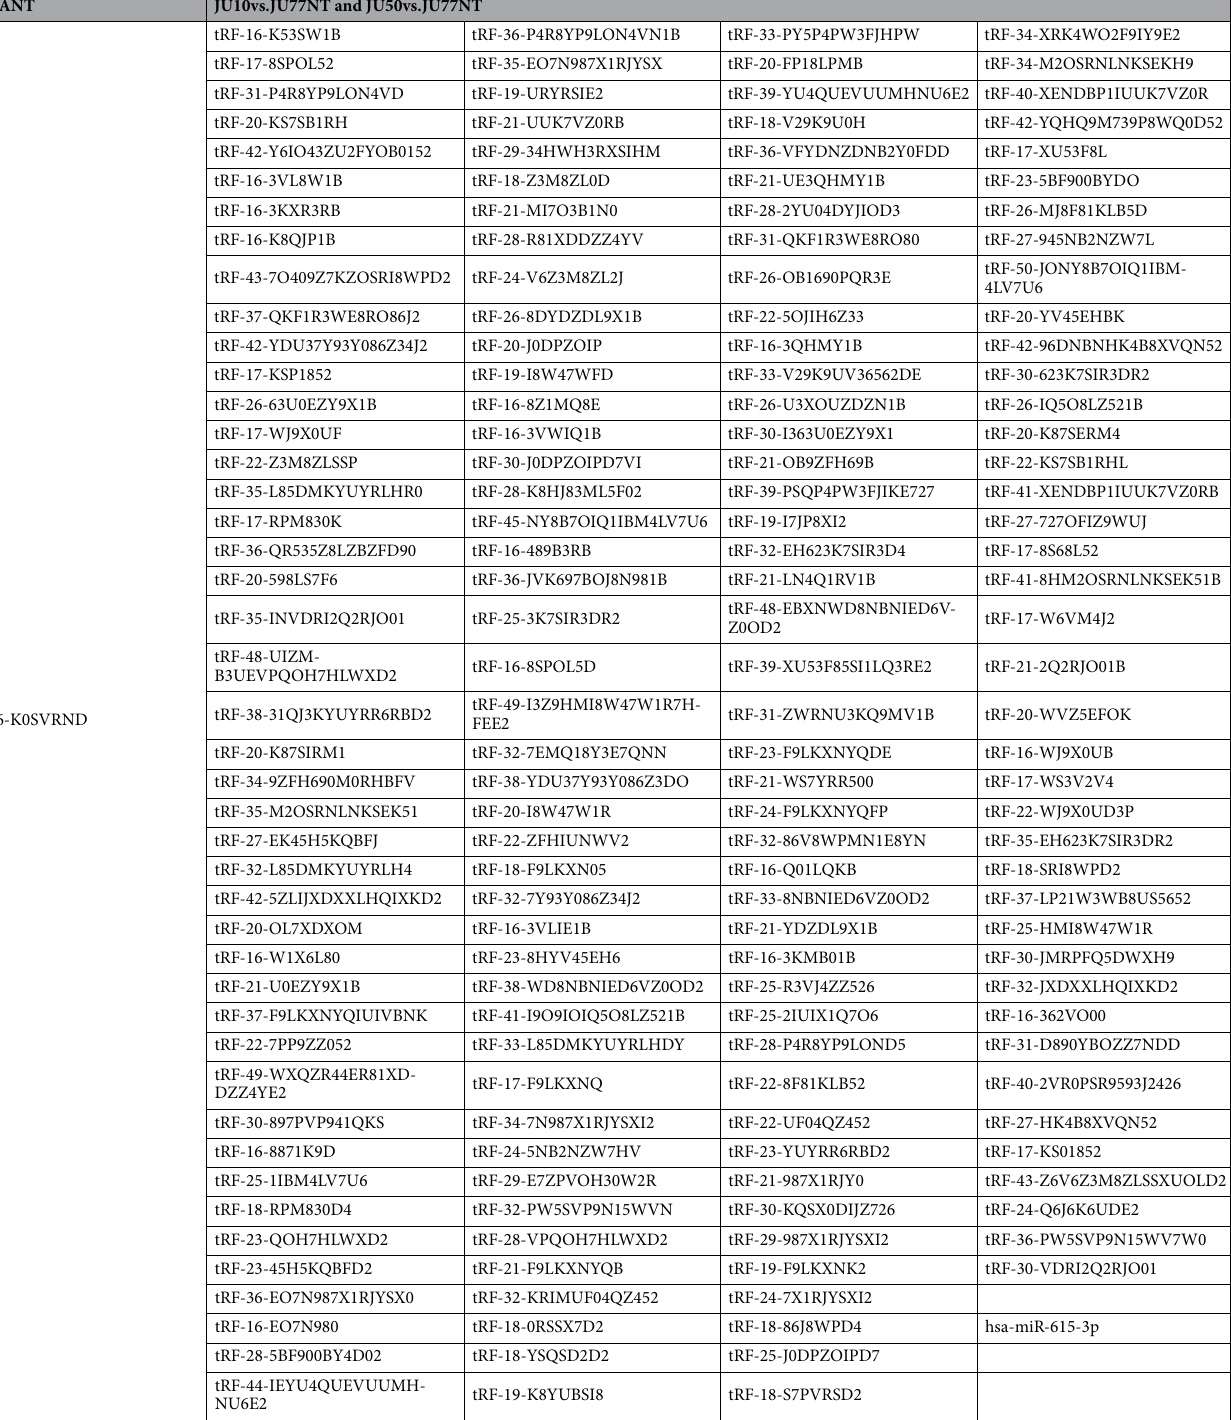
Table 5. Up-regulated ncRNAs in common among JU77 (human malignant mesothelioma) vs. MeT-5A (human normal mesothelium) in all tested